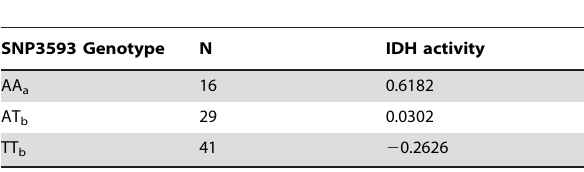
Table 3. IDH activity for three genotypic categories at